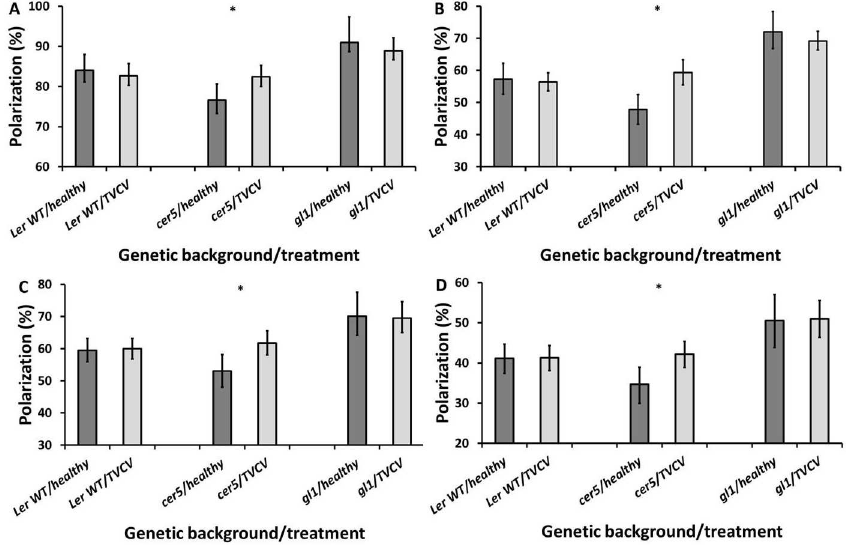
Fig 2. Average percentage polarization of light reflected from the adaxial (A,B) and abaxial (C,D) surfacesof healthy and TVCV-infected L er WT, cer5 and gl1 leaves, in the blue (A,C) and green (B,D) colour channels. Error bars denote95% confidenceintervalsof the means; asterisks denote the cases where the effect of infectionon the percentagepolarization reflection from mutant leaves is significantly different to the effect on WT leaves ( * P < 0.05). Imaging was performed at 21 days post-inoculation, on systemically infected rosette